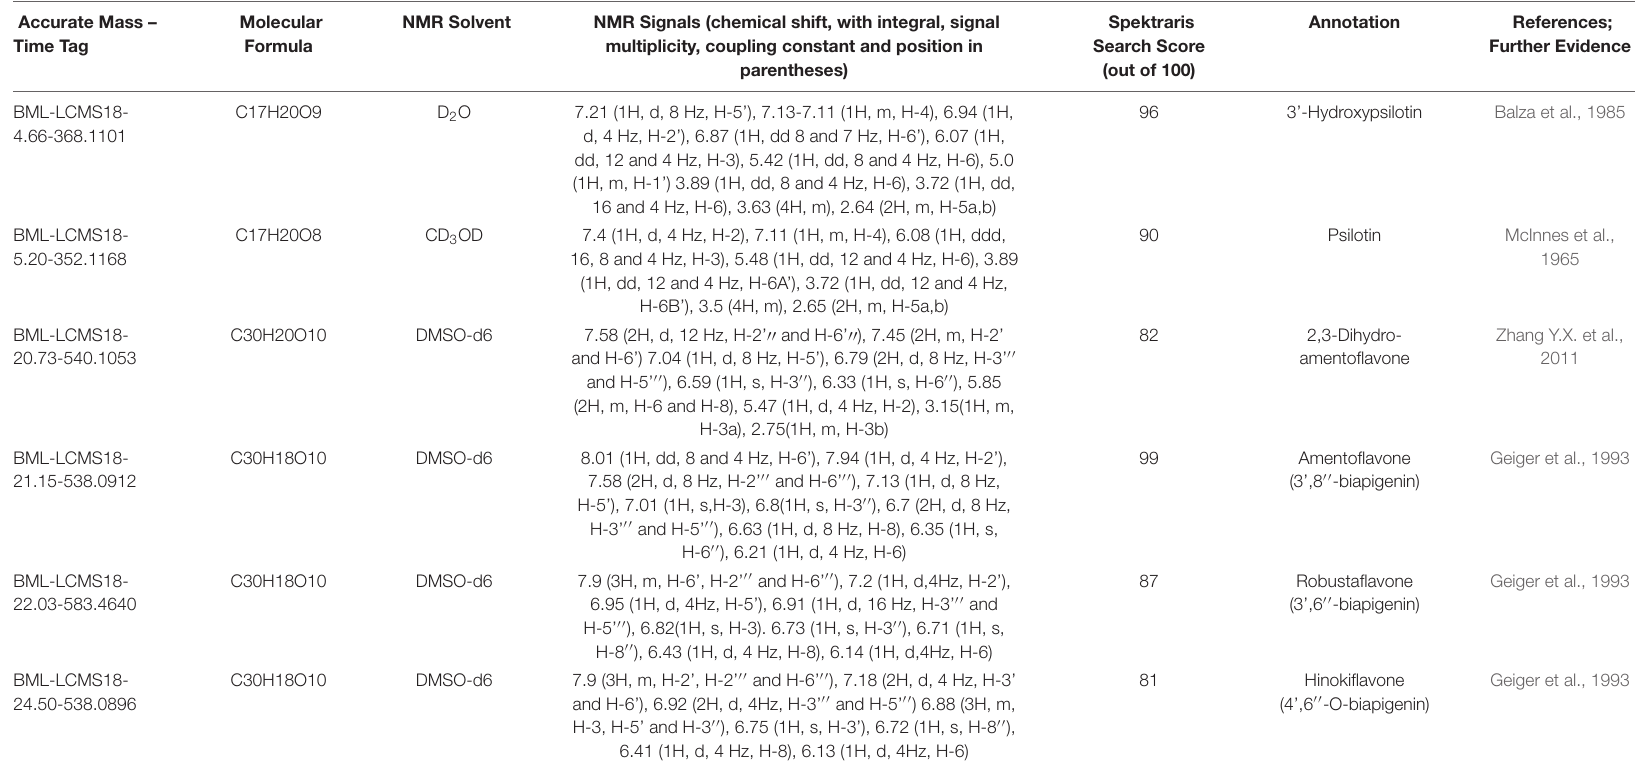
TABLE 2 | Peak annotation based on Spektraris searches with combined HPLC-QTOF-MS and NMR spectroscopy